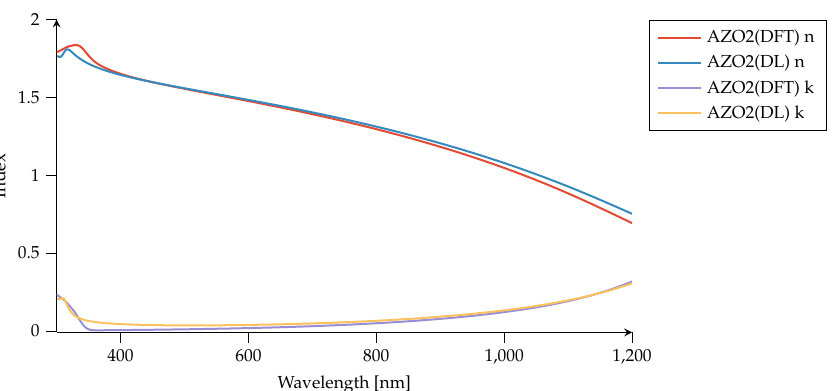
Figure 5. Aluminum-doped zinc oxide (AZO2) comparison of refractive indices (nk). Material models generated via density-functional theory (DFT) [47] are compared to the AZO2 material model generated by Drude–Lorentz (DL) parameters using PMCloud’s materials tool. We use (cid:101) ∞ =